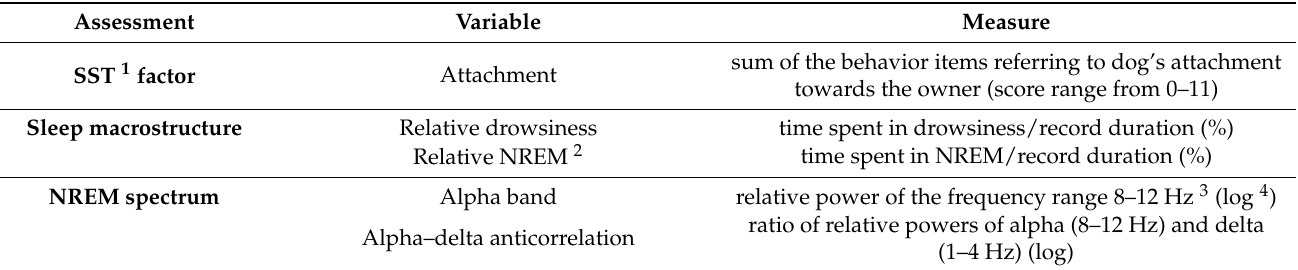
Table 2. Variables of interest measured by the behavioral test and the sleep